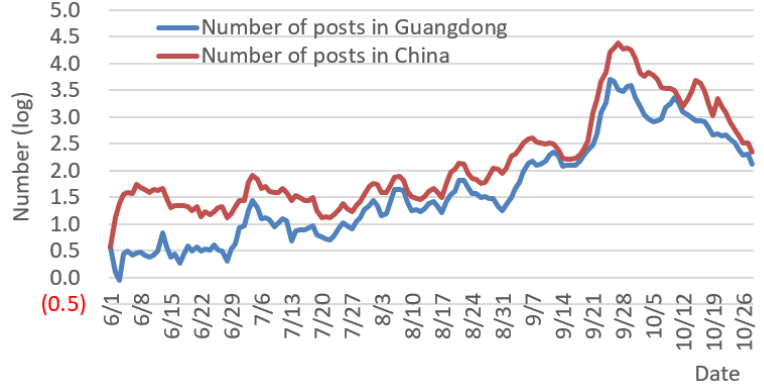
Figure 10. The number of Weibo posts related to dengue fever.